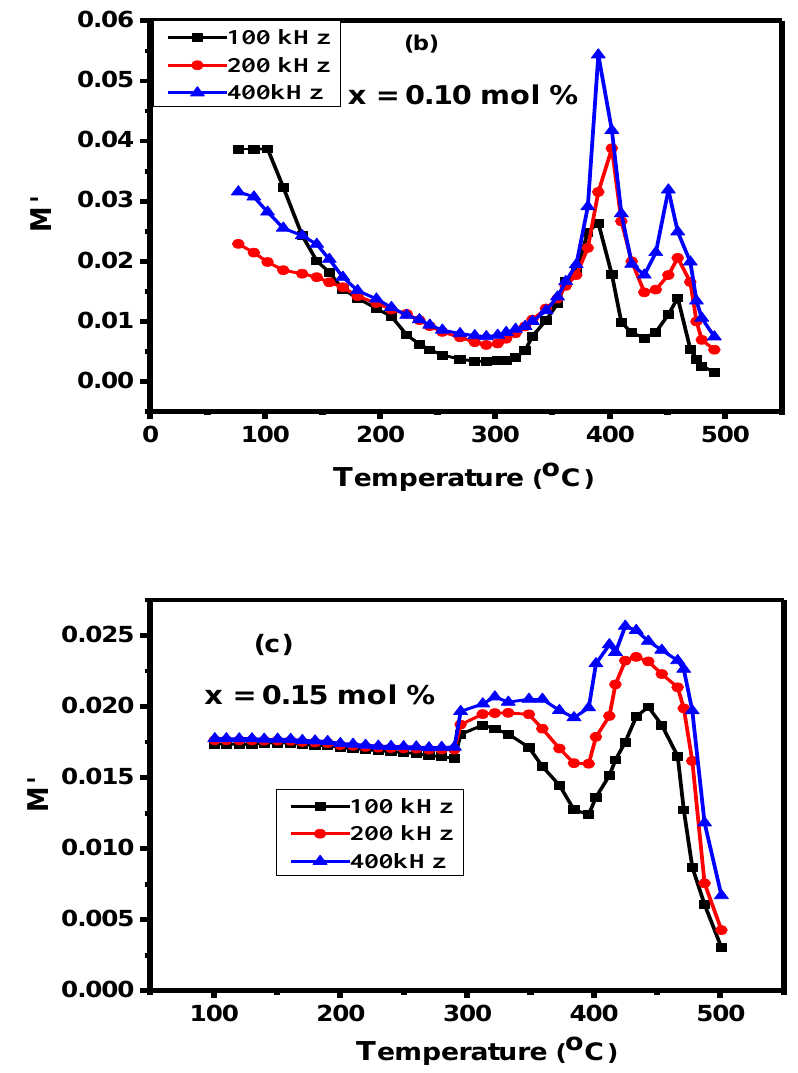
Figure 7. Variation of M′ of Co x :K 2 Ti 6 O 13 ceramics with temperature at 100, 200, and 400 kHz; ( a ) is for Co 0.05 :K 2 Ti 6 O 13 , ( b ) is for Co 0.10 :K 2 Ti 6 O 13 and ( c ) is for Co 0.15 :K 2 Ti 6 O 13 .